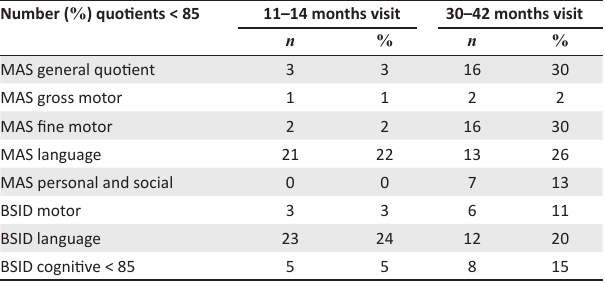
TABLE 2: Number (percentage) of Molteno Adapted Scale and Bayley Scales quotients below 85 signifying developmental risk at the 11–14 months ( n = 90) and 30–42 months ( n = 53) visits.